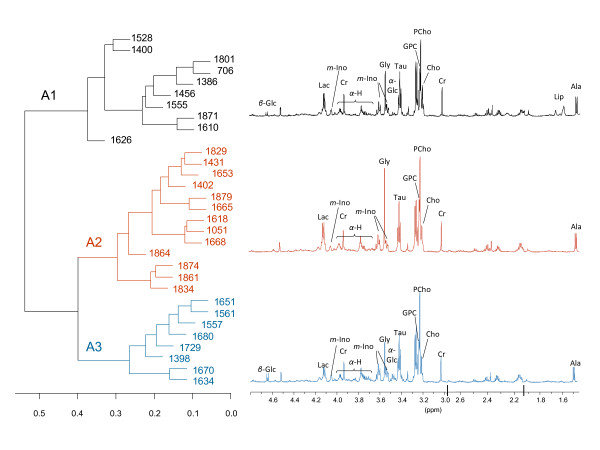
Metabolic subtyping of luminal A samples using hierarchical clustering. The HR MAS MR spectra of the samples classified as luminal A (N = 31), cluster in three groups using hierarchical clustering with Spearman's correlation as the distance measure and complete linkage. The mean spectra of each luminal A group are shown. Selected metabolite allocations are indicated with abbreviations (β-Glc: β-glucose; Lac: lactate; Cr: creatine; m-Ino: myo-inositol; α-H: α-H of amino acids; Gly: glycine; α-Glc: α-glucose; Tau: taurine; Cho: choline; GPC: glycerophosphocholine; PCho: phosphocholine; Ala: alanine). The spectral chemical shift-scale is non-continuous due to deletion of signals from lipid residues at 2.8 ppm and 2.05 ppm.